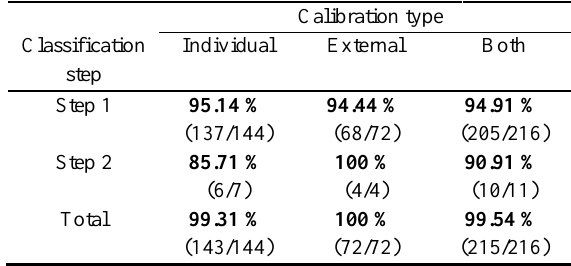
Table 3. Percentage of single movements correctly